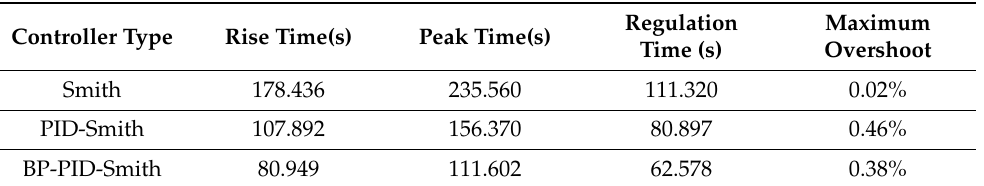
Table 5. Comparison of the dynamic performance of the three controllers at a fertilizer flow rate of 0.73 m 3